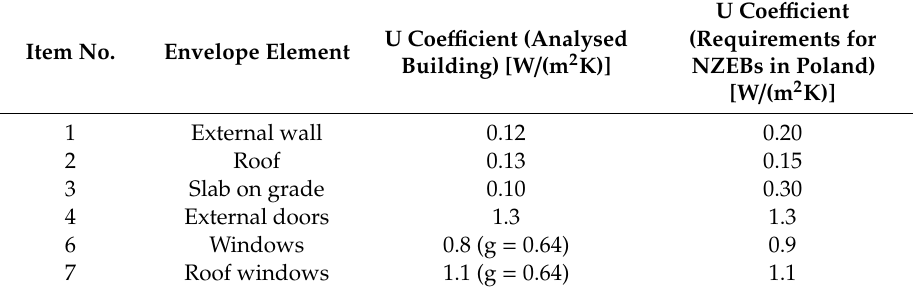
Table 5. Heat transfer coe ffi cients for elements of the buildings’